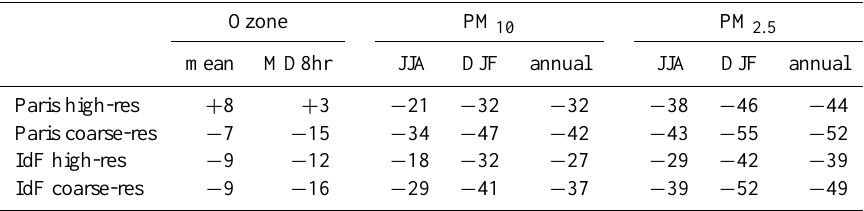
Table 6. Future concentration response relative to present (in %) under the high- and coarse-resolution applications over the city of Paris and the IdF